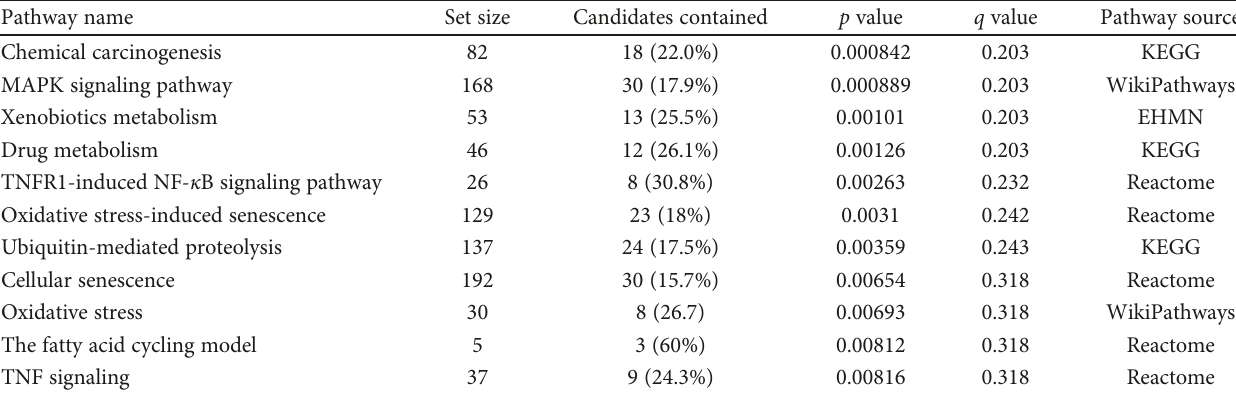
Table 3: Enriched pathway-based sets ∗ identi fi ed by ConsensusPathDB.